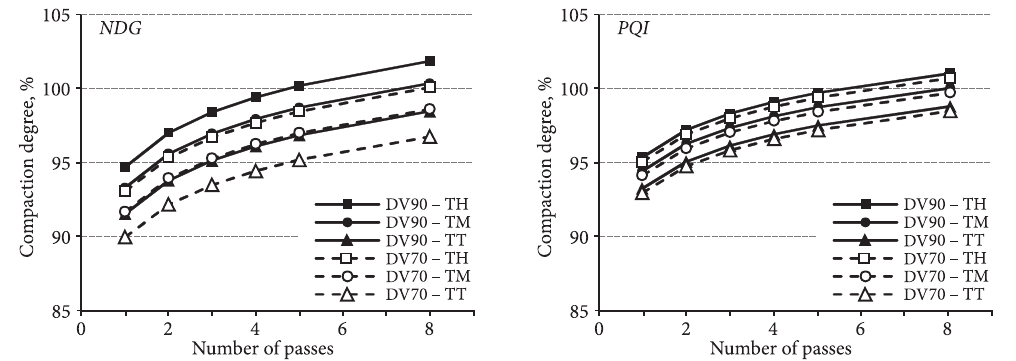
fig. 8. Base course CD prediction, by NDG (a) and PQI (b) regression models, with number of roller passes in S-S mode for the two rollers and at different temperatures